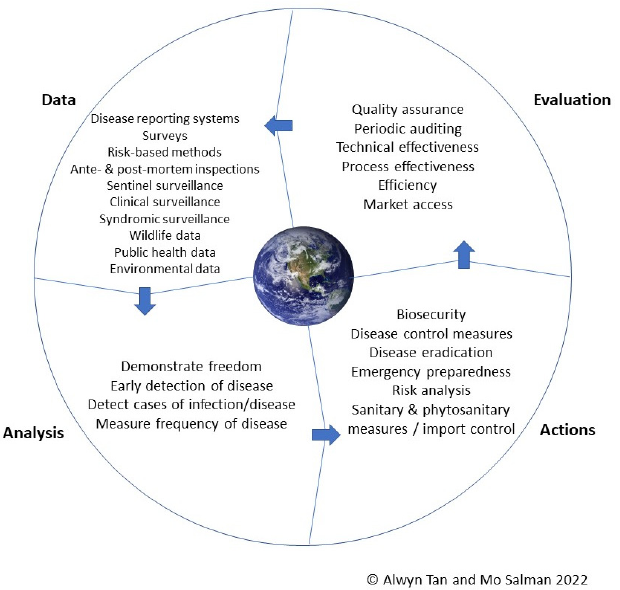
Figure 4. Animal health surveillance activities illustrated under a biosurveillance framework.